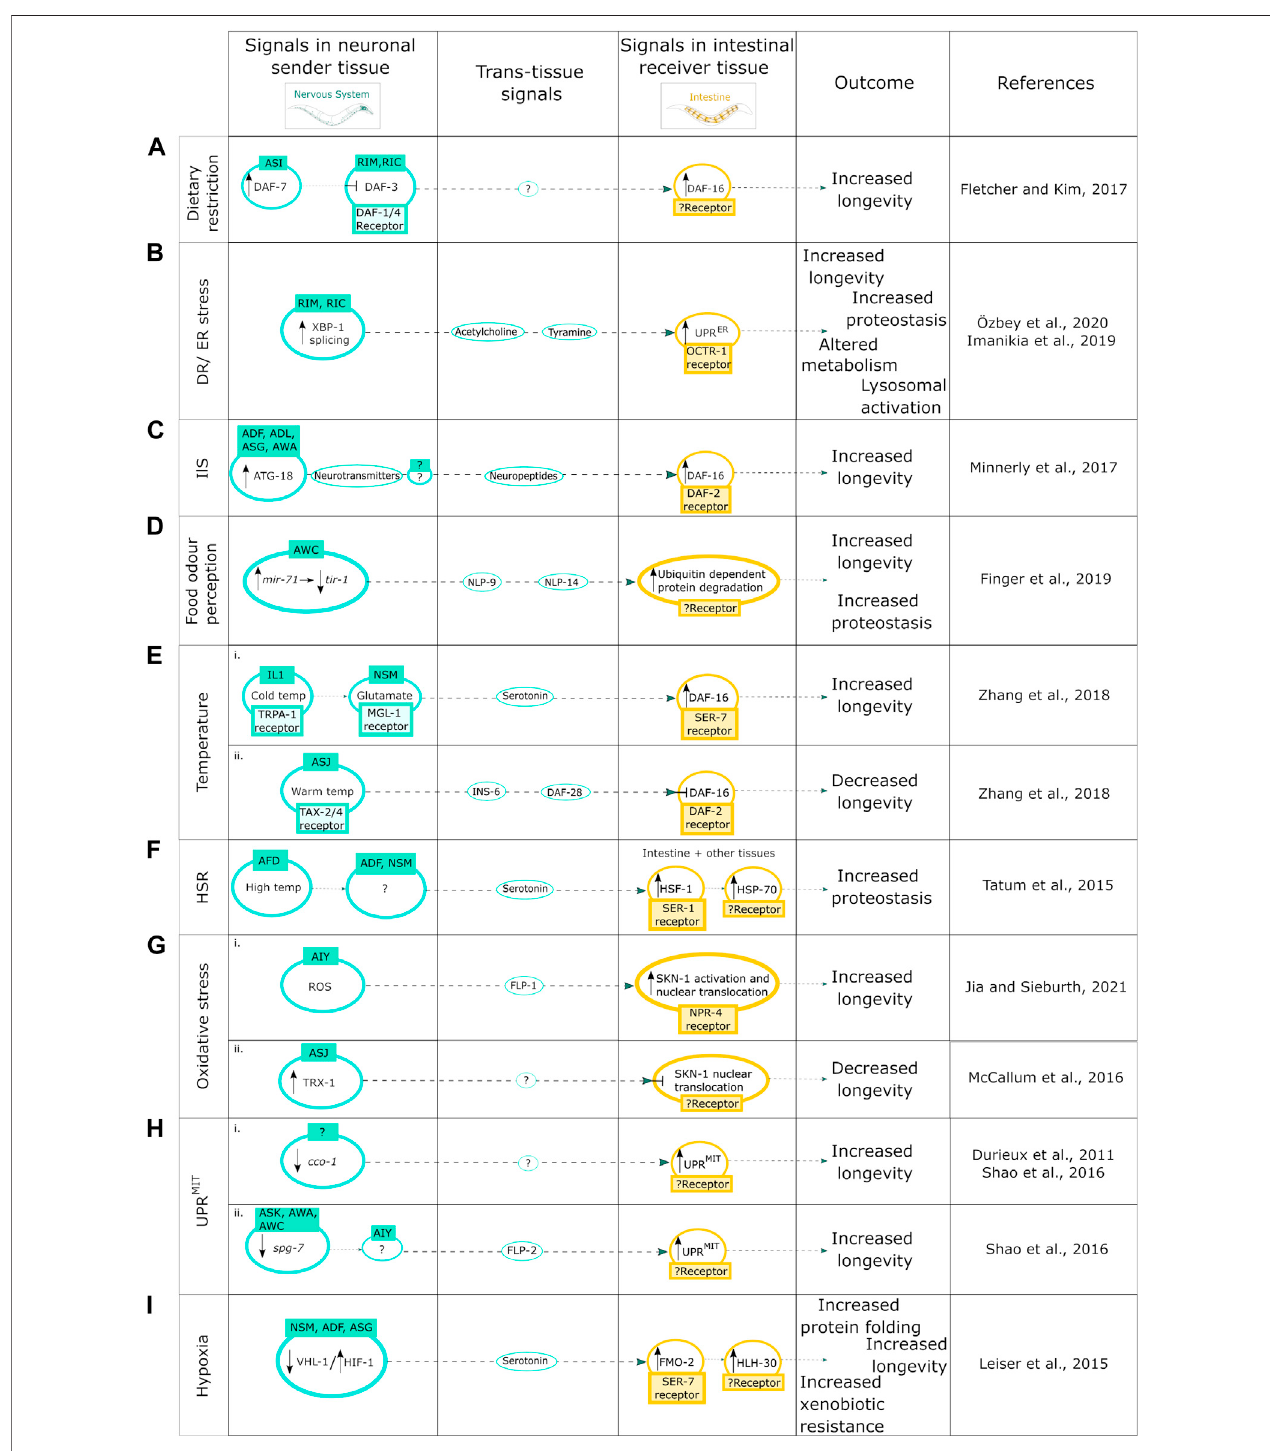
FIGURE1| Neuron-to-intestinecommunicationinorganismalproteostasisandaging. (A) MechanismofDRinducedneuronalcellnonautonomoussignalingupon expression of DAF-7. (B) DR/ER stress-induced neuronal cell nonautonomous signaling upon activation of the IRE-1-XBP-1 branch of the UPR ER . (C) Neuronal cell nonautonomous signaling upon increase of the autophagy protein ATG-18; (D) upon food odor perception through the miRNA pathway; (E) in response to (i) cold temperatureand(ii)hightemperature; (F) inresponsetotheHSR; (G) inresponsetooxidativestress;inducedby(i)ROS,(ii)TRX-1activation; (H) uponinductionof neuronal UPR MIT by the KD of the ETC component (i) cco-1 and (ii) spg-7 ; and (I) in response to hypoxia.